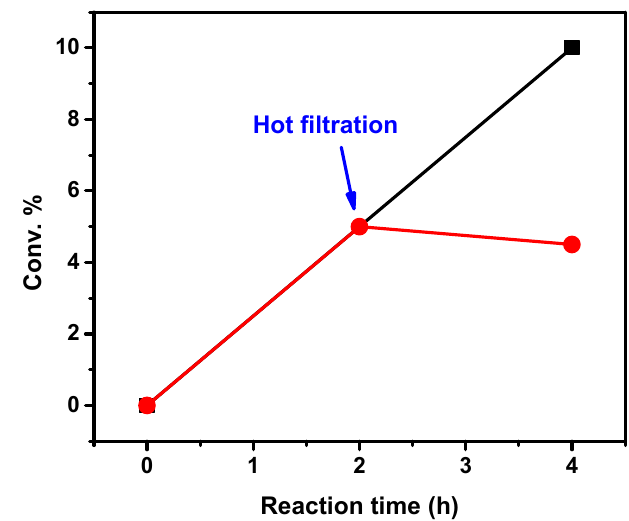
Figure 6. The conversion % of MIBK with-/out the hot filtration experiment. Reaction conditions: 170 °C, 25 mL of MIBK (solvent free), 0.25 g catalyst, 2 wt% of metal, 10 bar H 2 pressure, stirring rate of 780 rpm.